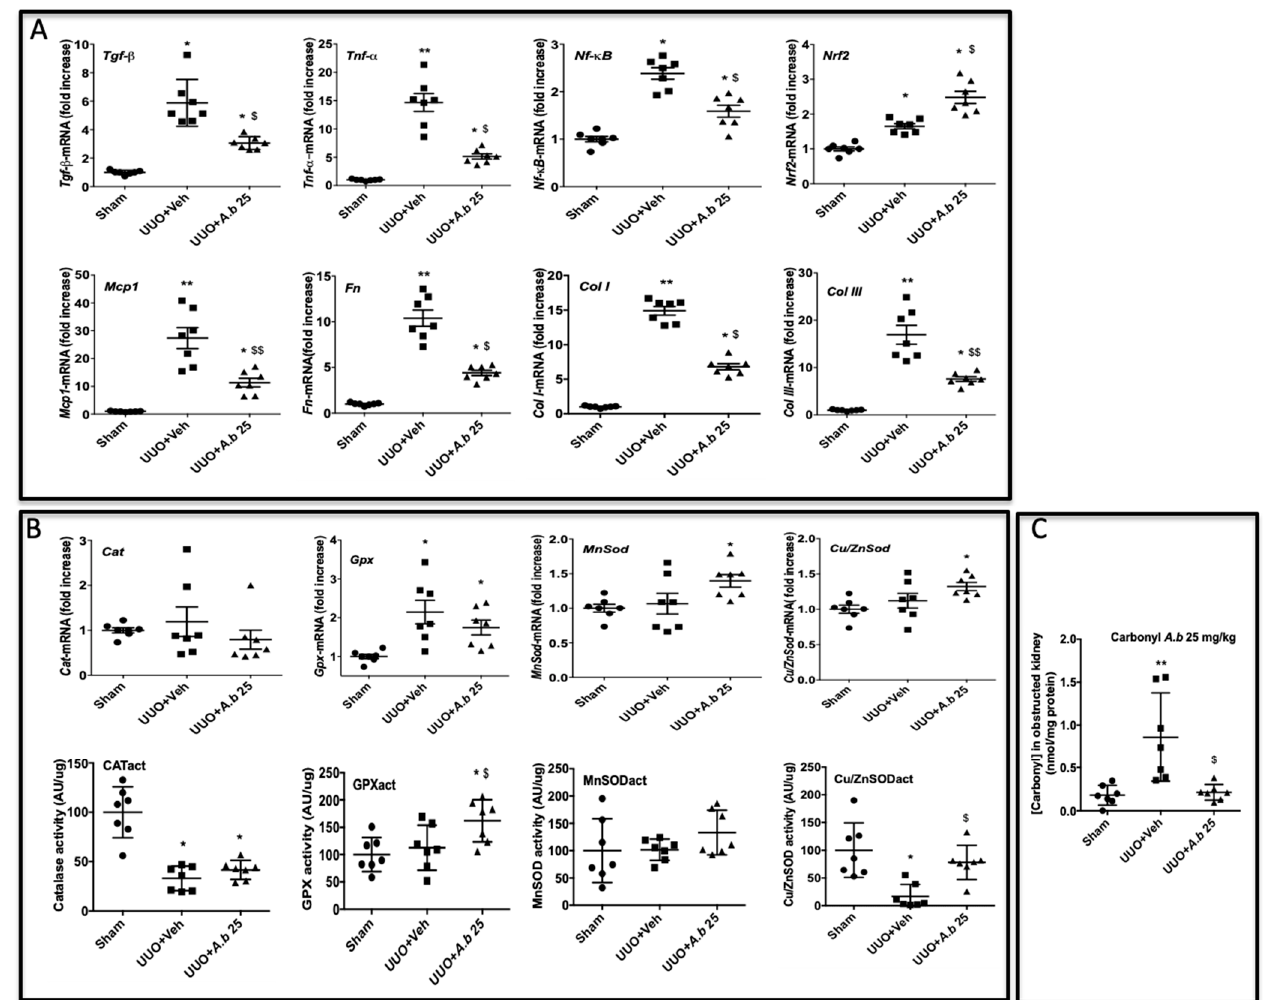
Figure 4. A. borbonica ( A. b ) extract restores normal inflammatory and oxidative stress states induced by unilateral ureteral obstruction (UUO). ( A ) Expression of genes involved in inflammatory and fibrotic responses in obstructed kidney, ( B ) antioxidant enzyme expression and activity (act) and ( C ) protein carbonyl concentration in obstructed kidney. n = 7 per group. * p < 0.05, ** p < 0.01, compared to Sham; $ p < 0.05, $$ p < 0.01 compared to UUO + Veh.